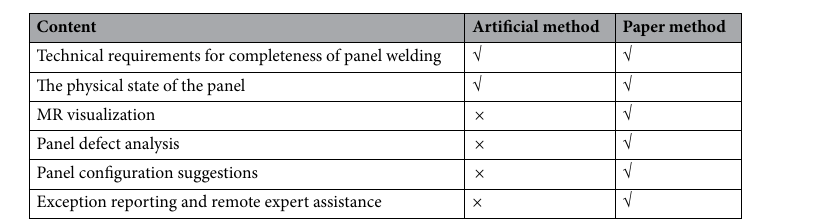
Table 3. Comparison of main indexes between traditional manual method and this method.